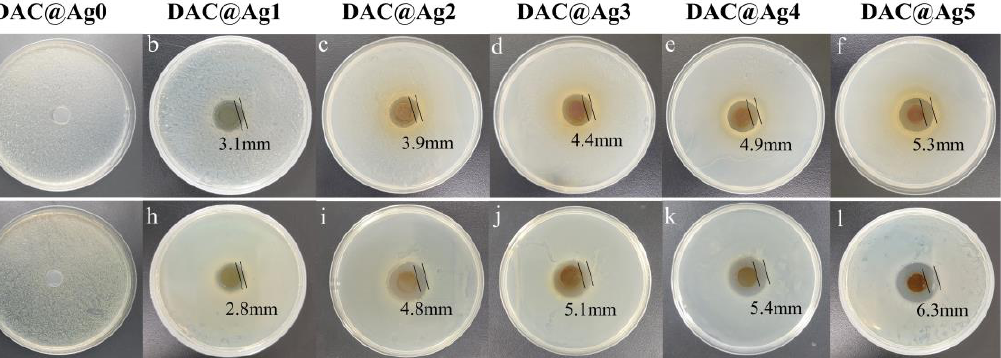
Figure 8. Water vapor transmission rate (WRT) ( a ), water absorption ( b ), water contact angle ( c ), and bacterial inhibition zone ( d ) of DAC@Ag0-DAC@Ag5 films.